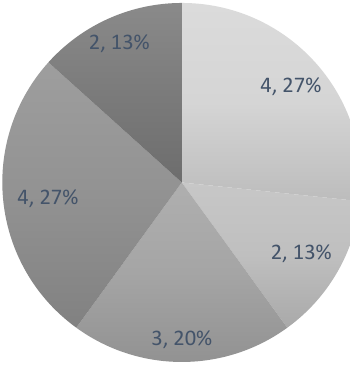
Figure 2. A pie chart representing the distribution of data on HIV services. Approximately 36% of the studies reported on HIV testing, 36% reported on antenatal care, and 27% reported on ART initiation. Only two studies reported on ART initiation. This shows that there is not enough data available for ART initiation, which should be considered as an area of future observation. Two studies did not specify the type of HIV service being reported. (HIV = Human Immunodeficiency Virus; ART = Antiretroviral therapy).